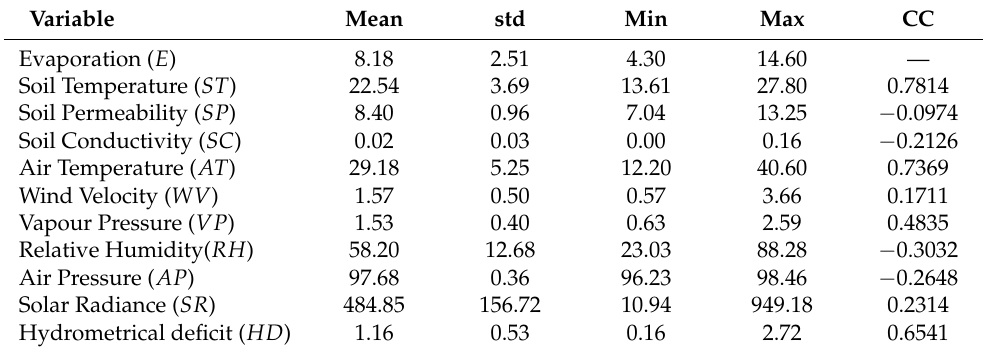
Table 1. Variable descriptive statistics. Mean, standard deviation (std), minimum (Min) and maxi- mum (Max), and correlation with the measured evaporation